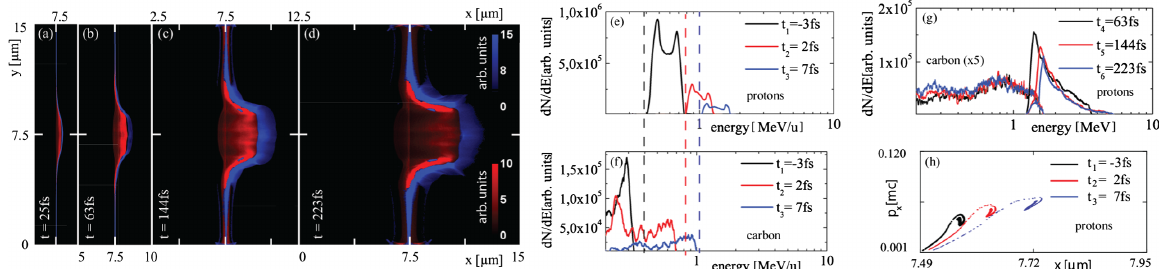
FIG. 3. Data from 2D-PIC simulation. (a)–(d) Spatial proton (blue) and carbon (red) ion density distribution in the x - y plane at different times (given in the figure caption) after the arrival of the peak of the Gaussian (in space and time) laser pulse. The spectral evolution during the laser-target interaction of protons (e), carbon ions (f), and after the interaction (g). In (h) the proton phase space during the interaction is revealing the characteristic spiral structure for